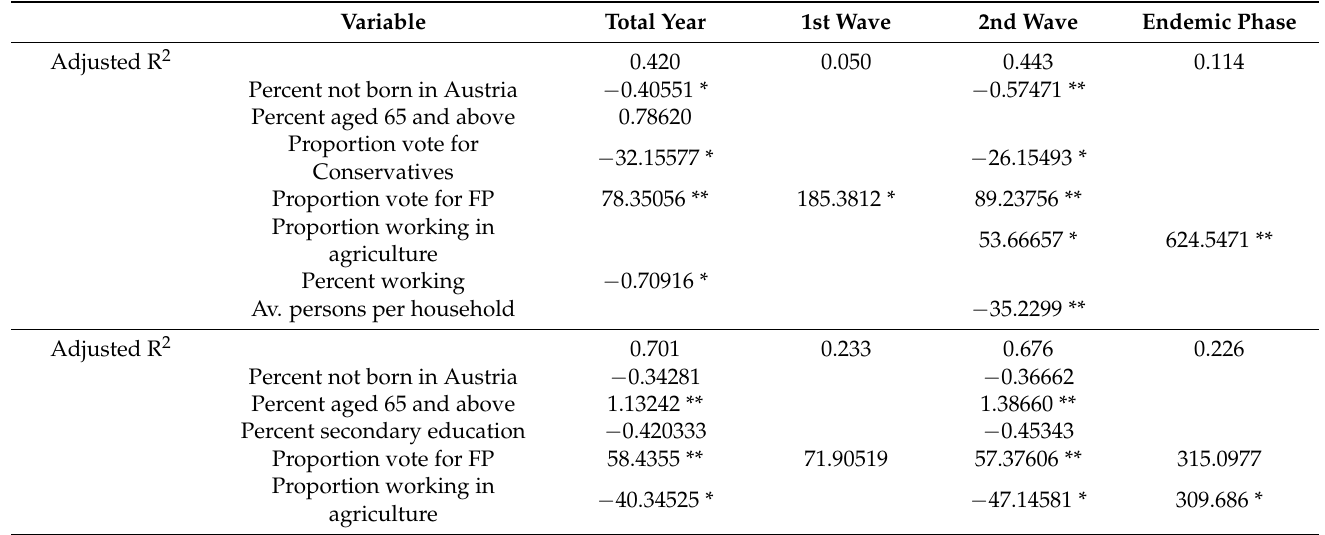
Figure 5. Scatterplots for right-wing voters and never-smokers on lethality and mortality. The final regression models for deaths per diagnosed cases as indicator of lethality are presented in Table 4. Univariate correlation coefficients between deaths per cases and independent variables are presented in Appendix A (Table A3). Overall, a higher percentage of inhabitants not born in Austria, as well as a larger average number of household members, tends to reduce the risk of dying from COVID-19, while the risk of dying was higher in a district with a high amount of FP voters (Table 4). Table 4. Coefficients of the final linear regression model for death per 1000 cases. Upper part: federal country not considered; lower part: federal country